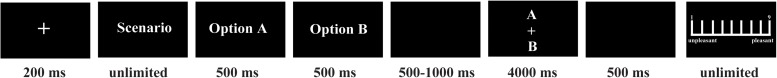
Sequence of events in the experiments of Study 1.